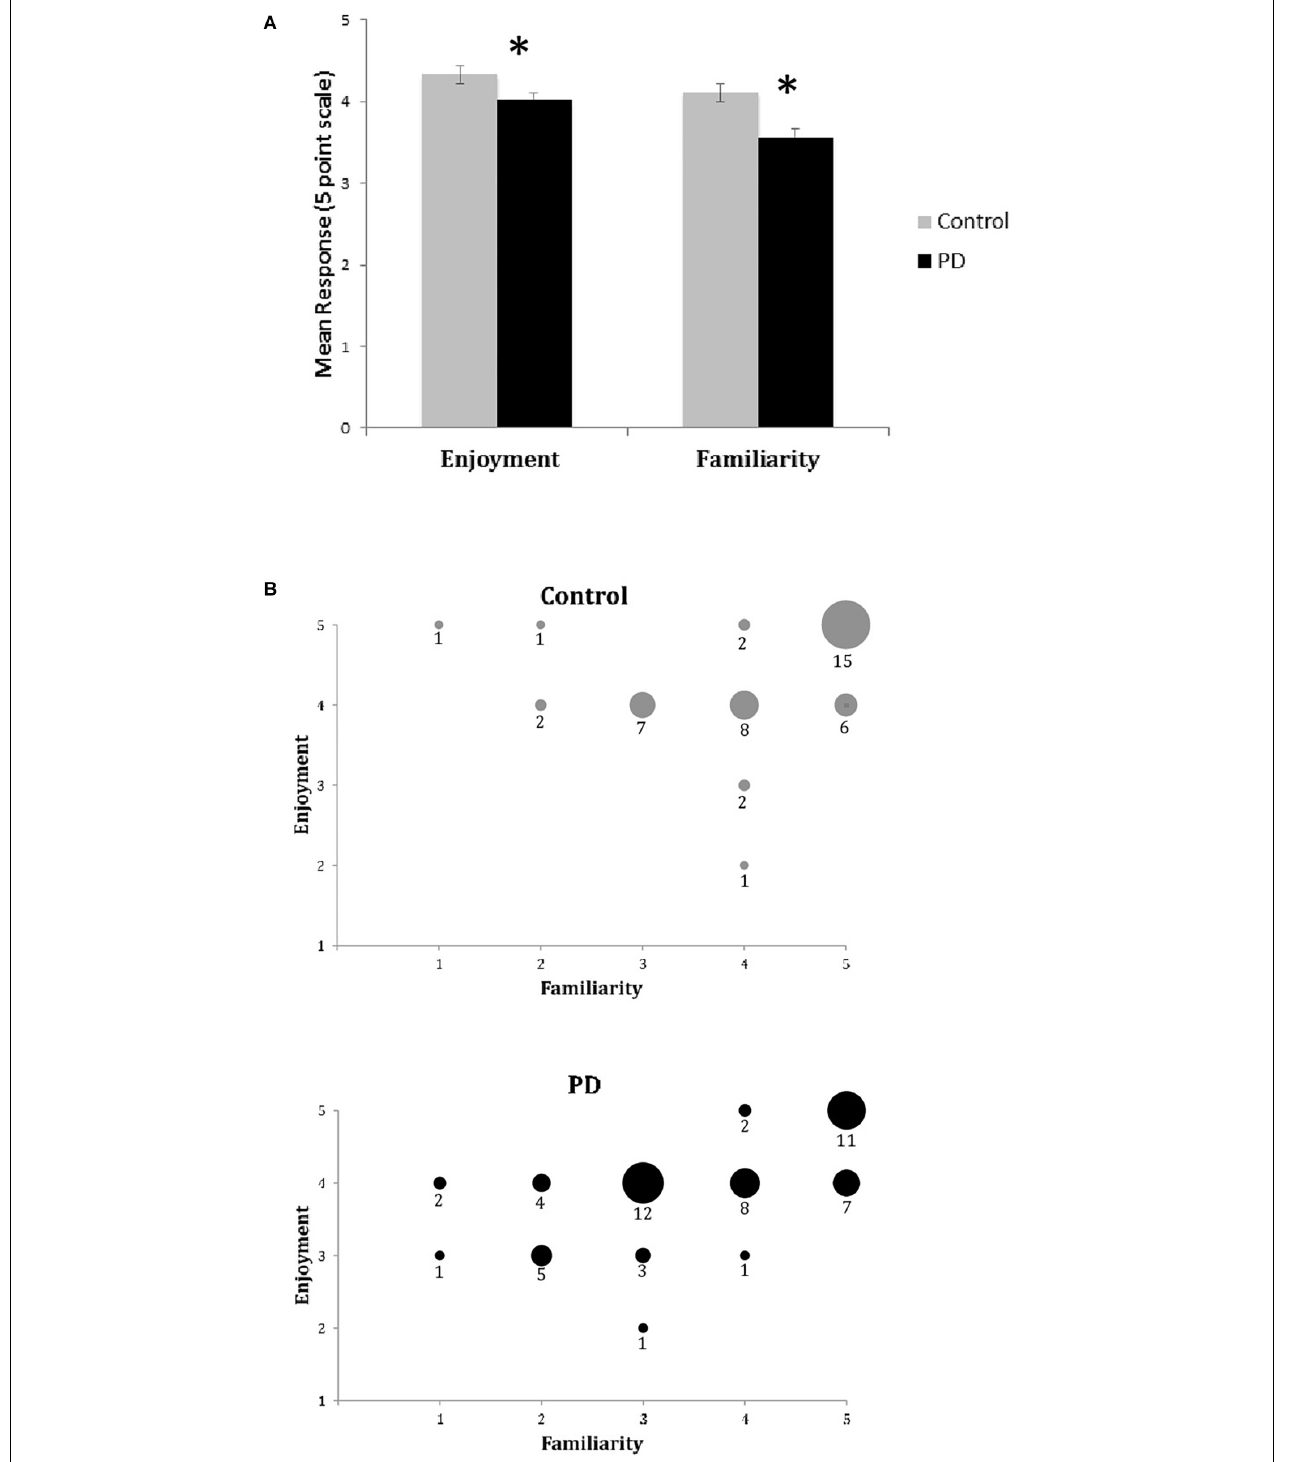
FIGURE 2 | Exit Survey results of music enjoyment and familiarity. (A) Mean responses ( ± SEM) for enjoyment and familiarity on the Exit Survey for healthy controls (Gray) and participants with PD (Black). Asterisks ( ∗ ) indicates significance at p < 0.05 as determined by Mann–Whitney U test. There were significant between group differences for both enjoyment and familiarity. (B) Enjoyment plotted against familiarity for control (top) and PD (bottom) groups. Responses for all songs and all participants are included in dataset. Size of circle and numbers below indicate the number of participants from each group who responded at that coordinate for the three